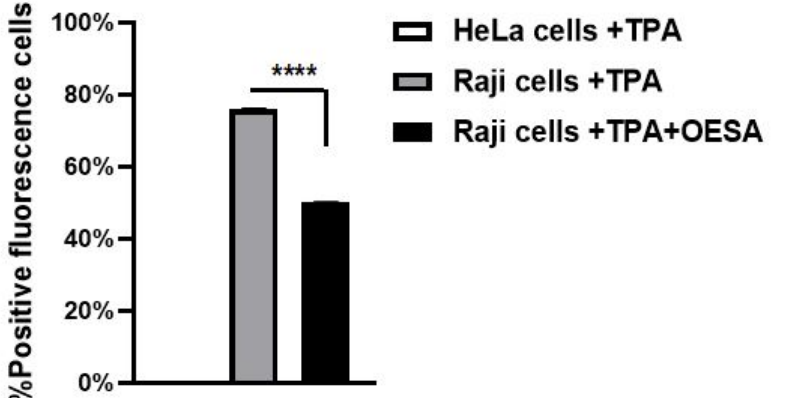
Figure 6. Antiviral effect of OESA in the Raji cells line. Raji cells were stimulated with TPA, exposed to OESA (0.31 mg/mL), incubated with primary antibody, and labeled secondary antibody. The values represent the percentage of fluorescence cells. Asterisks indicate significant differences compared to OESA-untreated sample. (**** p < 0.0001). Results were expressed as mean ± standard deviations (n = 3).